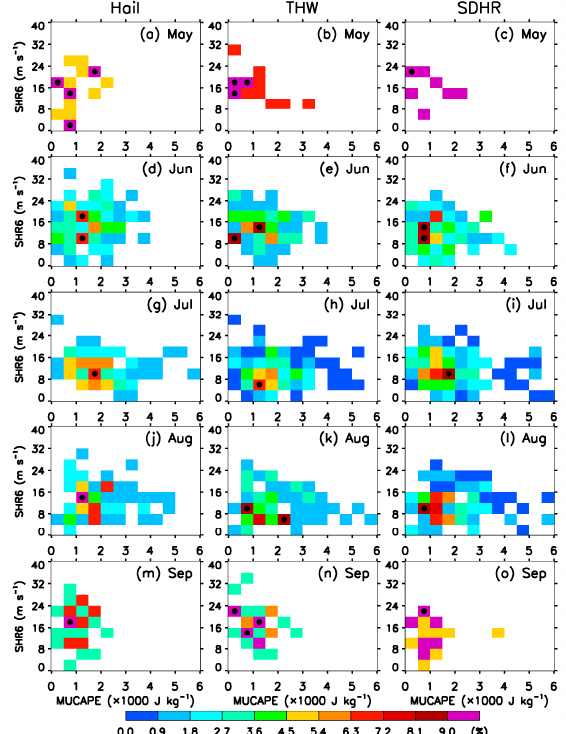
Figure 11. Probability distribution of the occurrence frequencies of ( a , d , g , j , m ) hail, ( b , e , h , k , n ) THW, and ( c , f , i , l , o ) SDHR events in different months over the mountains in the paired MUCAPE–SHR6 space. Panels ( a – c ), ( d – f ), ( g – i ), ( j – l ), and ( m – o ) represent events that occur in May, June, July, August, and September, respectively. Black dots indicate the grid(s) with the maximum